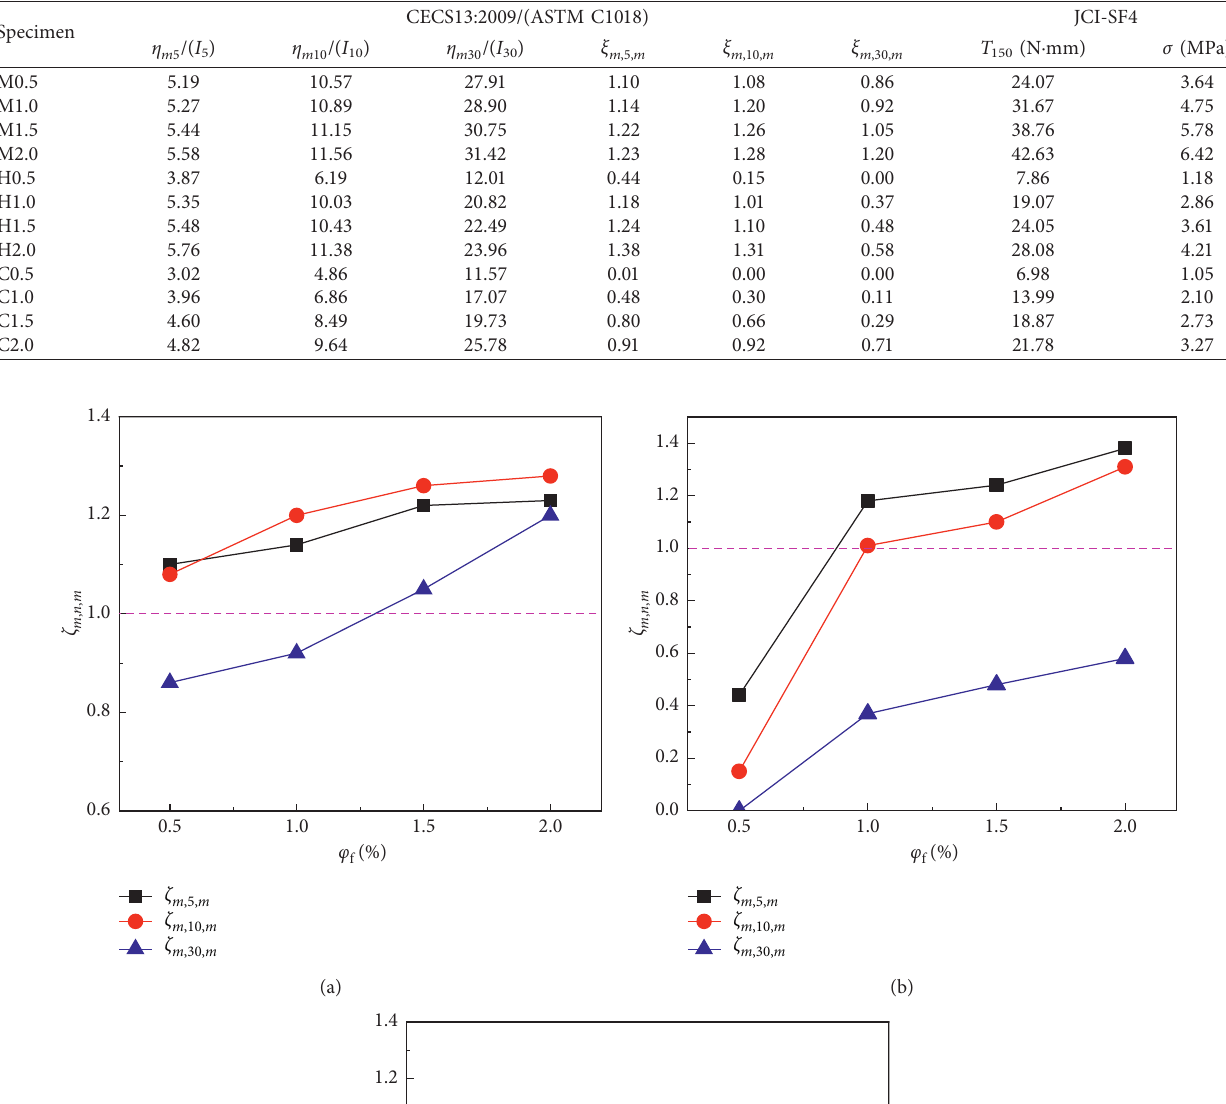
Table 5: First-crack flexural strength and toughness indices.